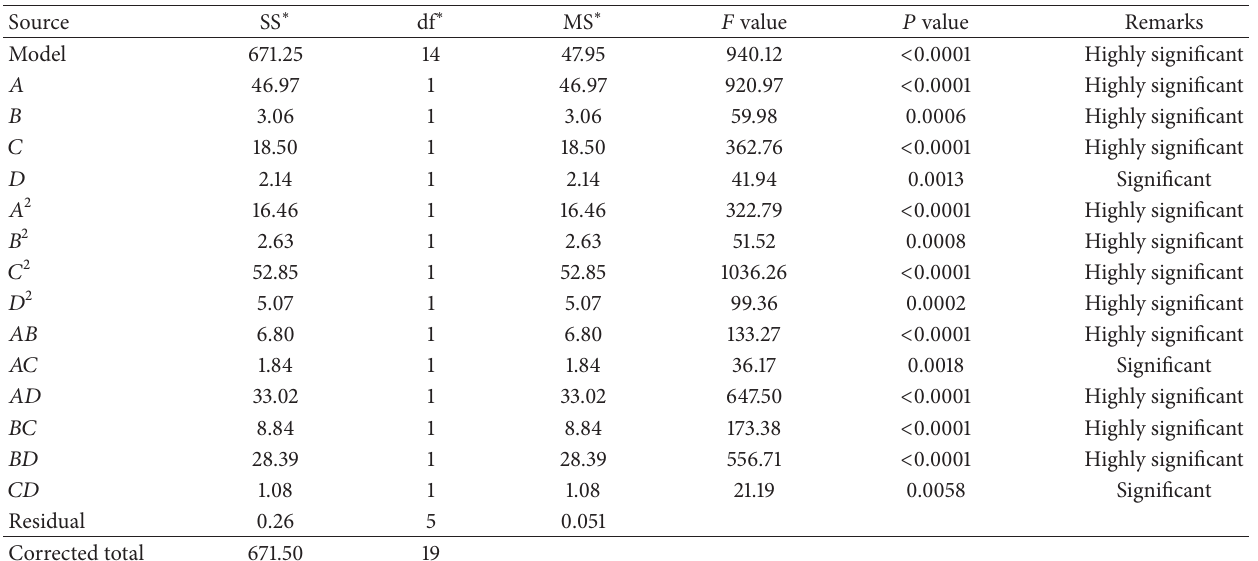
Table 4: Analysis of variance of the fitted quadratic regression model (3).